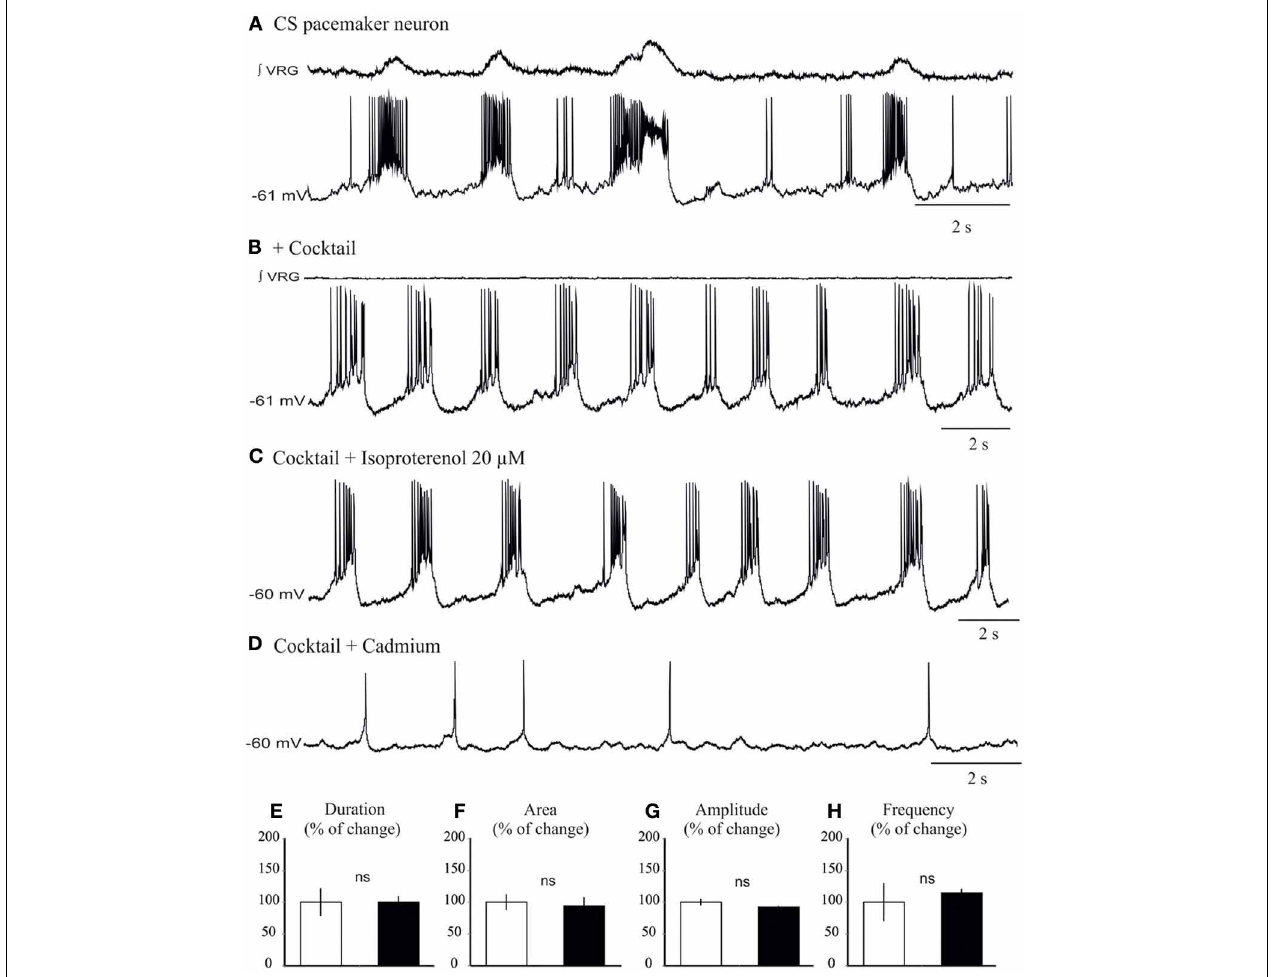
neurons. (D) Application of cadmium 200 μ M abolishes specifically bursting properties of this pacemaker neuron. Note the neuron continues to spontaneously generate action potentials (E–H) Histograms show no effects of isoproterenol on burst duration (E) , area (F) , burst amplitude (G) , and burst frequency (H) . These effects were quantified by obtaining for each pacemaker neuron the average burst duration, area, and frequency from 15 successive cycles (ns: not significant, n = 4).